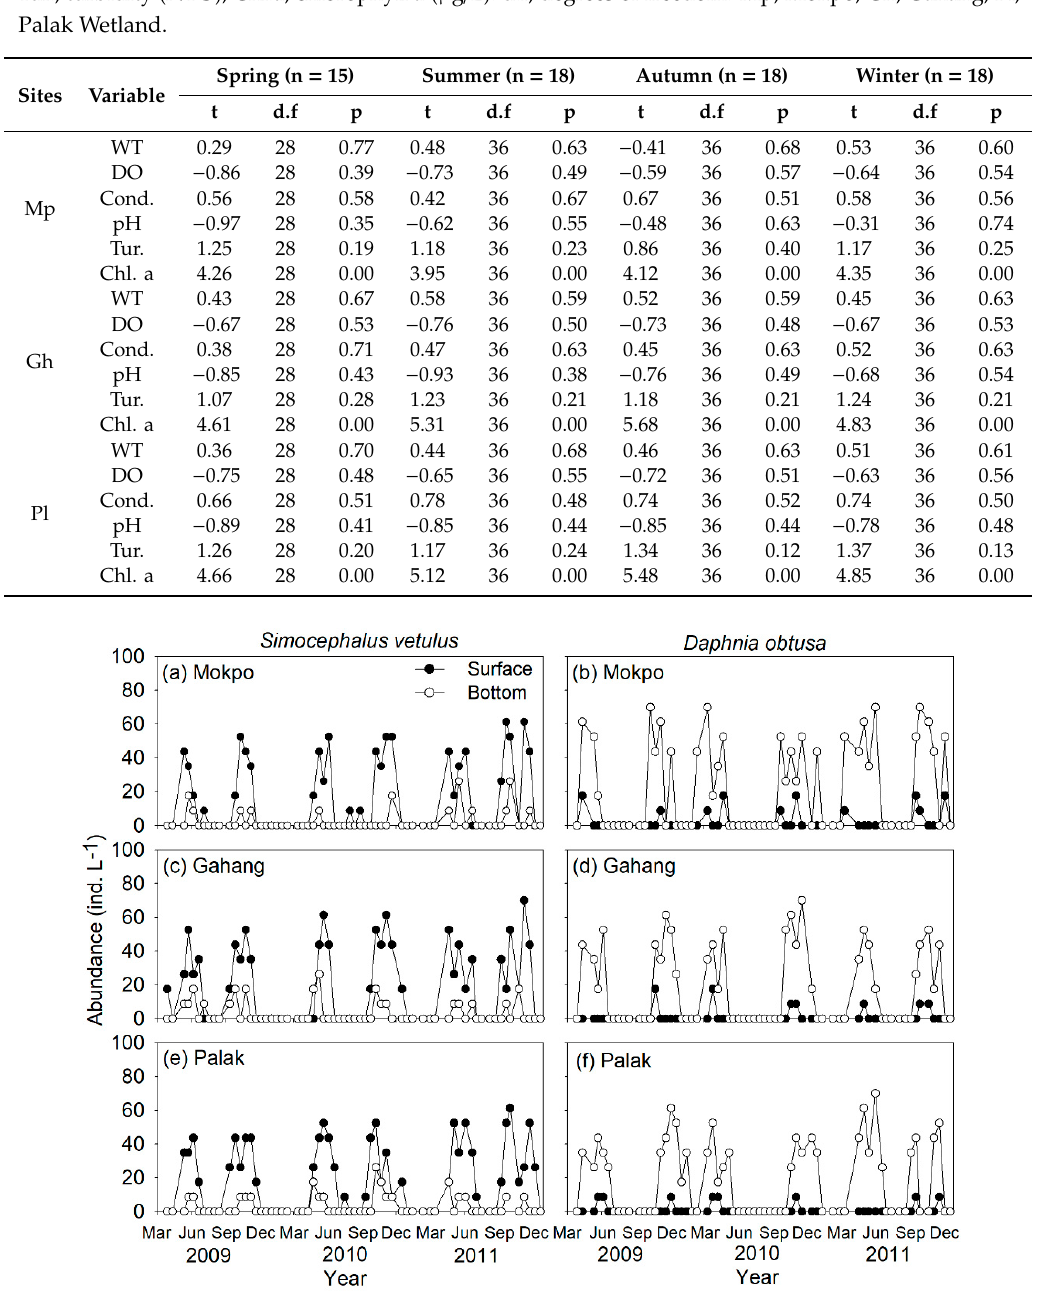
Figure 4. Spatial and temporal distribution pattern of Simocephalus vetulus and Daphnia obtusa at each study site during the study period (March 2009 to February 2012; three years). Panels ( a ), ( c ), ( e ) show changes in S. vetulus distribution in the surface and bottom of Mokpo, Gahang, and Palak wetlands. Panels ( b ), ( d ), ( f ) show the same for D. obtusa .